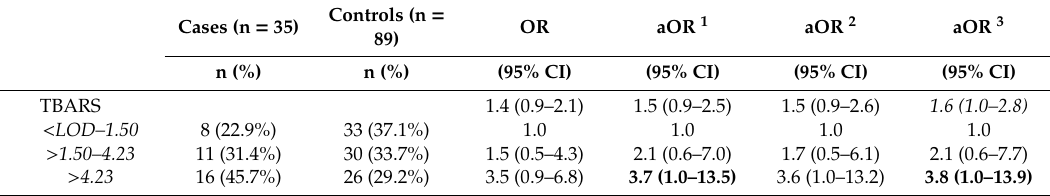
Figure 1. Adjusted odds ratios (OR) for endometriosis in the tertiles (T) of urinary concentration of BPA and Σ bisphenols. * p -value < 0.050. Table 4. Association between urinary TBARS levels and